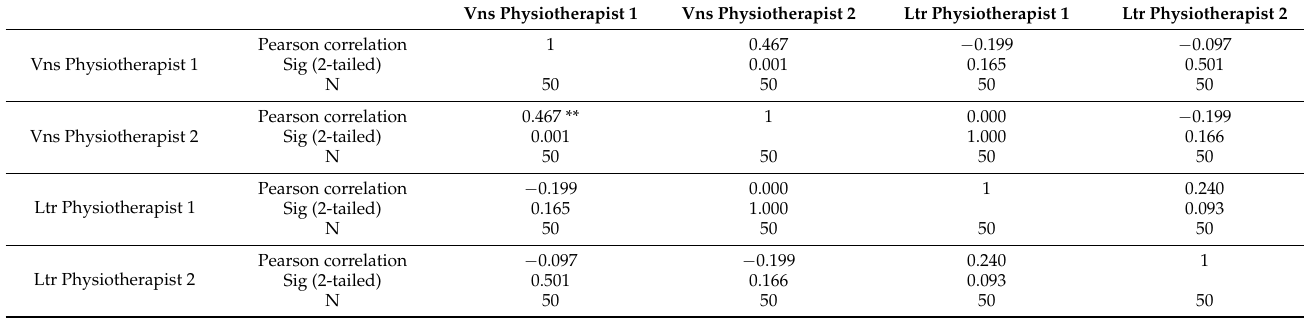
Table 4. Correlation between the VNS and the local spasm response.